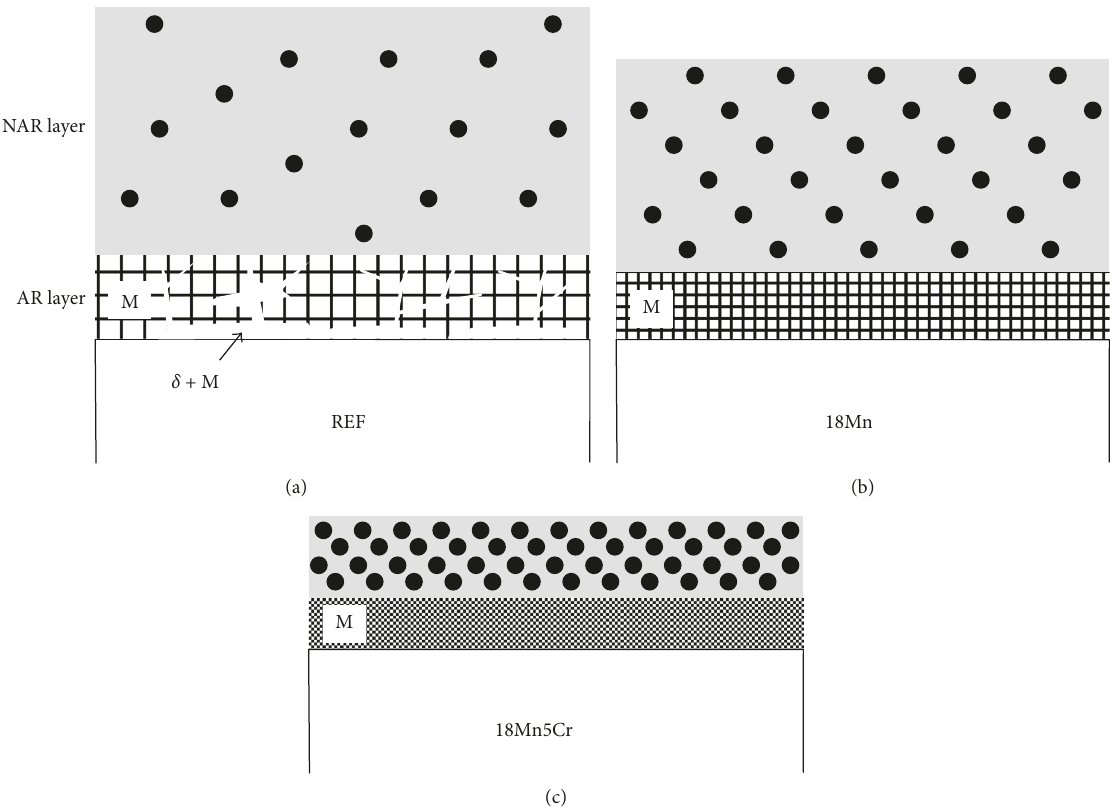
Figure 10: Schematic diagrams of rust layers formed on REF (a), 18Mn (b), and 18Mn5Cr (c) in 3.5% NaCl solution for 56 days at 60 ° C, where solid circle, M, and δ indicate goethite, magnetite, and feroxyhyte,